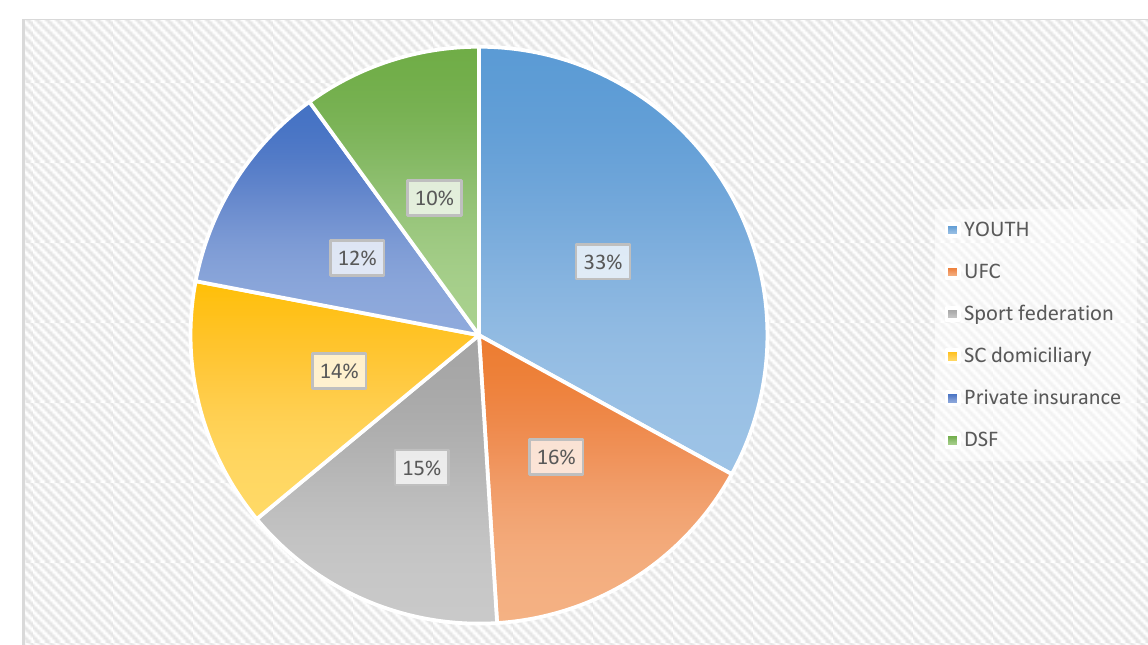
Fig. 2. Organization to ensure the development of youth reserve sports: A - YOUTH; B - UFC; C- Sport federation; D- SC domiciliary; E- Private insurance; F - DSF